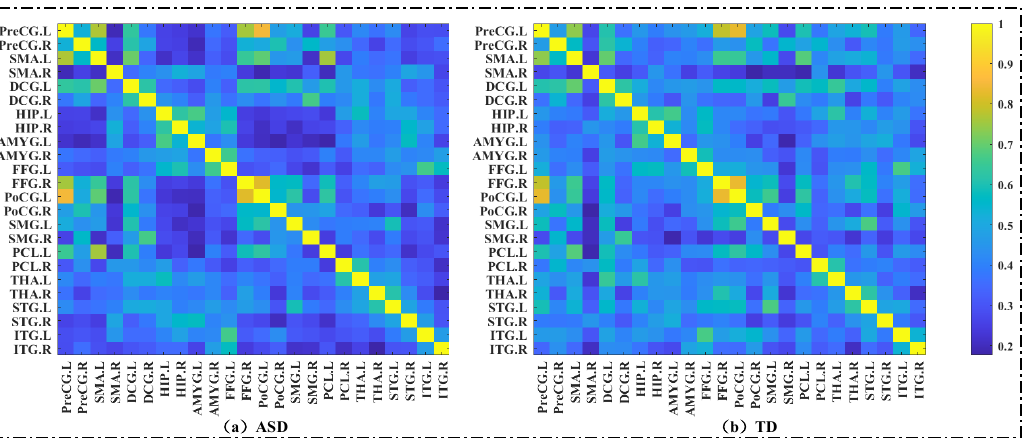
Figure 1. The averaged brain networks of the ASD and TD groups. ( a ) The averaged brain networks of the ASD group. ( b ) The averaged brain networks of the TD group.